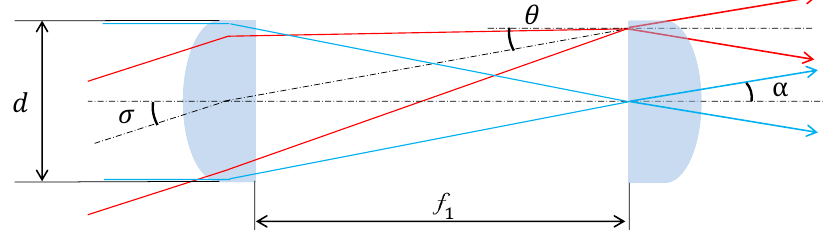
Figure 4. Expanation how the second LA revise the initial divergent angle from the light source, d , α and f 1 are the same as in Figure 3.